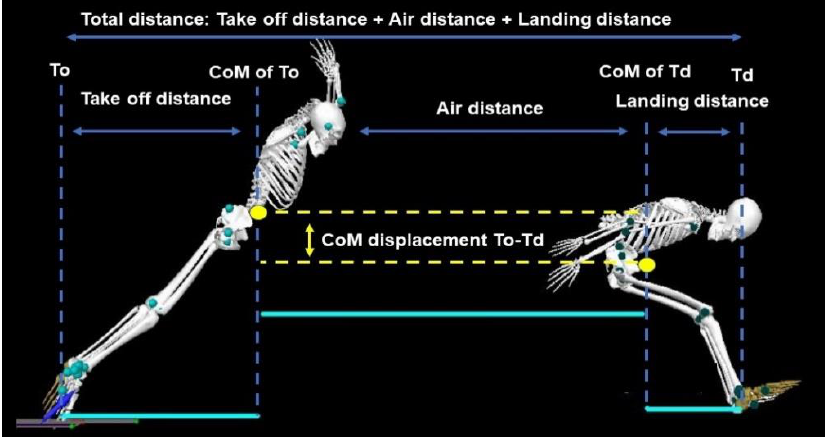
Figure 1. Definition of main distances in the standing broad jump. To = take-off; CoM = center of mass; Td = touch-down.